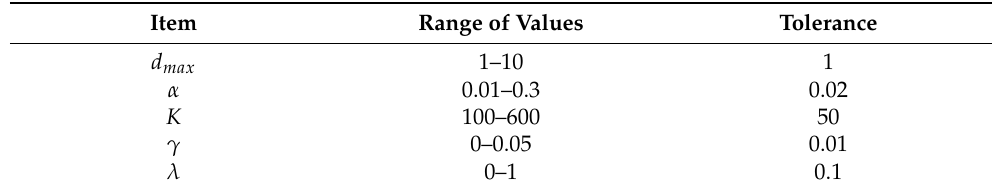
Table 3. Hyperparameter ranges for model fine-tuning.